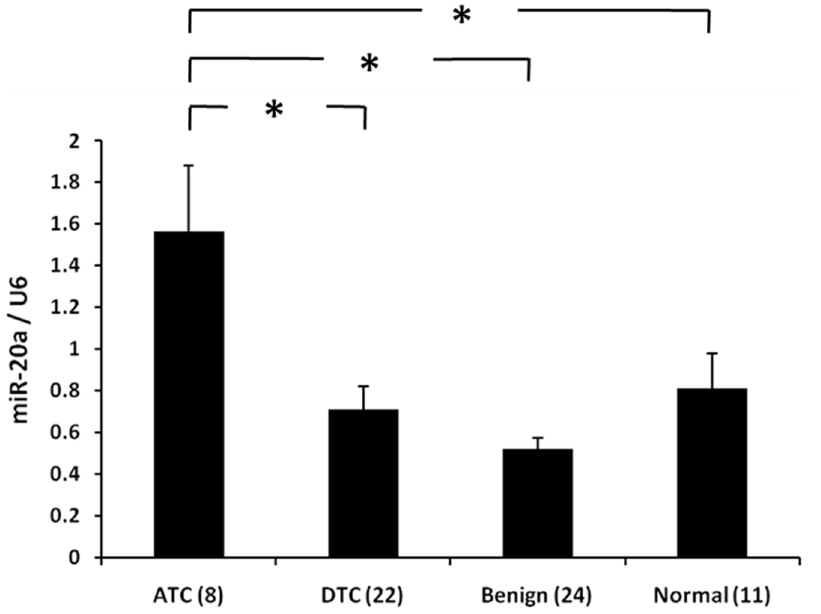
Figure 1. Expression level of miR-20a in human thyroid tissue samples. Y axis represents relative miR-20a expression level normalized to U6 (2 2 DD Ct value). Quantitative real-time PCR was performed using total RNA from 65 human tissues (8 ATCs, 22 DTCs, 24 benign, and 11 normal). Error bars represent standard error of mean (* indicates p , 0.05).